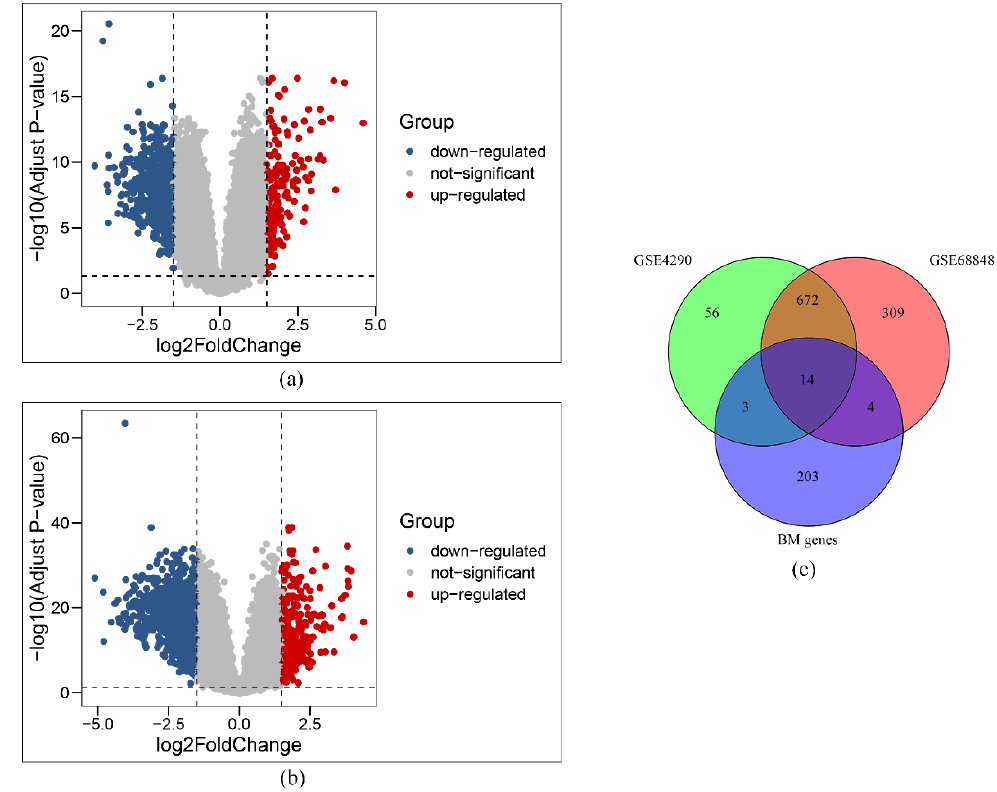
Figure 2. Identification of DEGs in BM-related genes. Volcano plots showing the DEGs in GSE4290 ( a ) and GSE68848 ( b ). VENN plot showing the intersection of DEGs and BM-related genes ( c ).